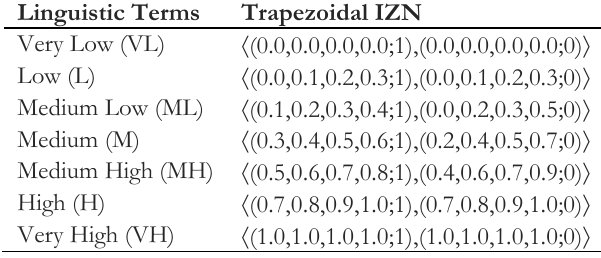
Table 1. IZN corresponds to linguistic terms for the restriction component.